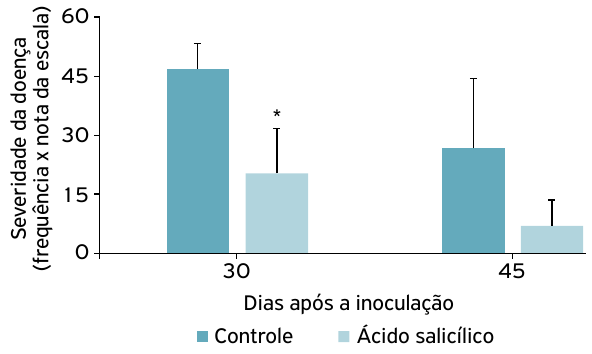
Figura 1. Severidade do endurecimento dos frutos em maracujazeiro‑amarelo em função do tratamento com ácido salicílico 2,5 mM e controle (etanol 10%), pulverizados uma única vez, em condições de casa de